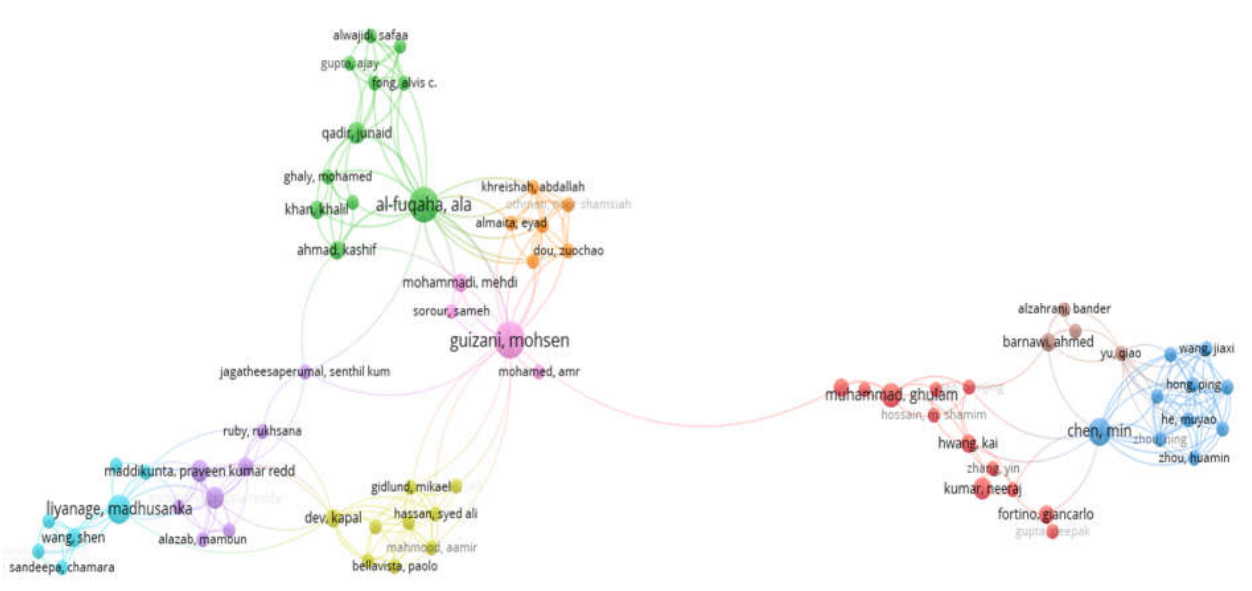
Figure 1. VOSviewer mapping of remote big data management tools, sensing and computing technologies, and visual perception and environment mapping algorithms in the Internet of Robotic Things regarding co-authorship.